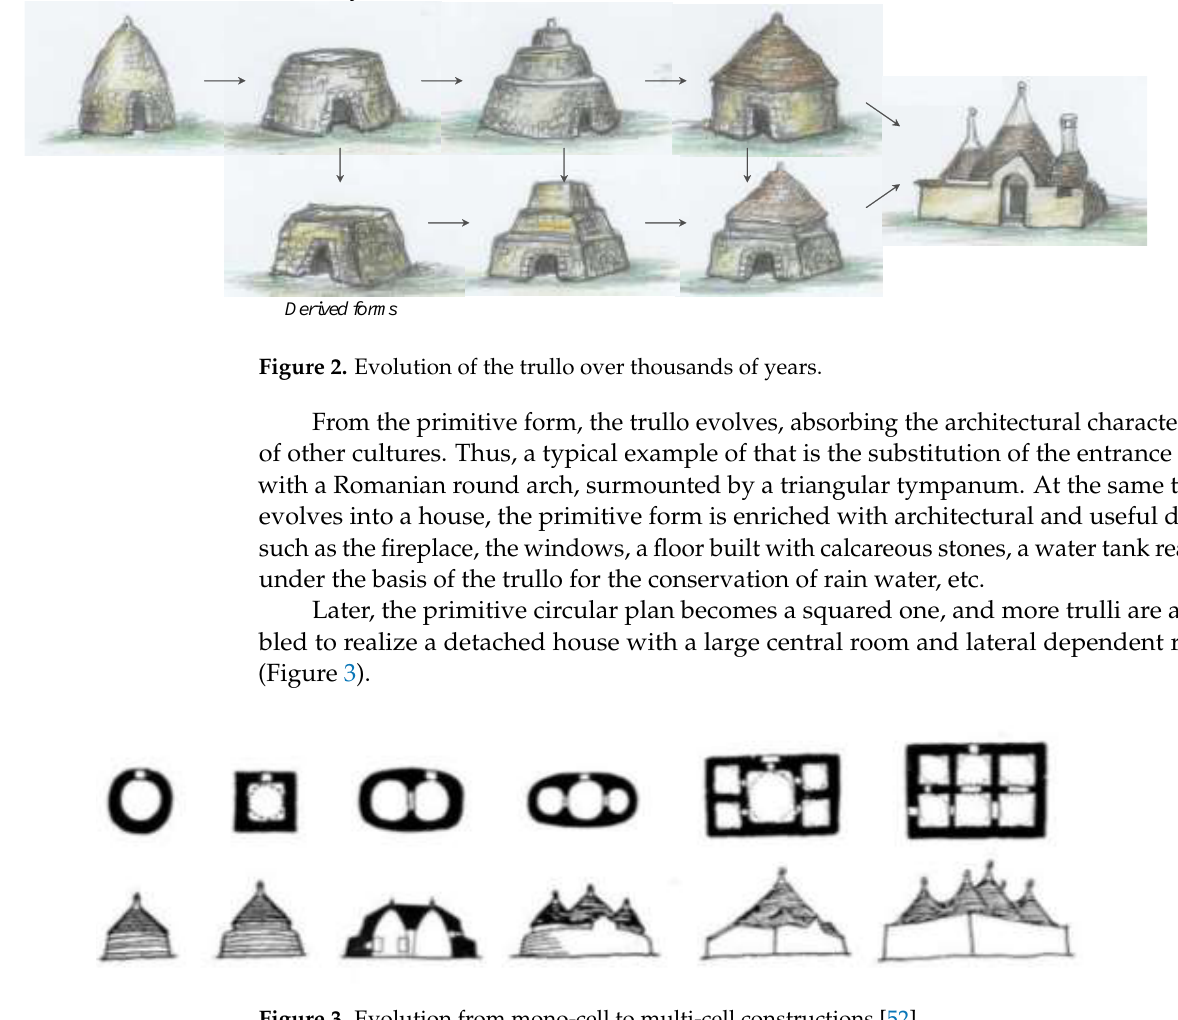
Figure 3. Evolution from mono-cell to multi-cell constructions [52].